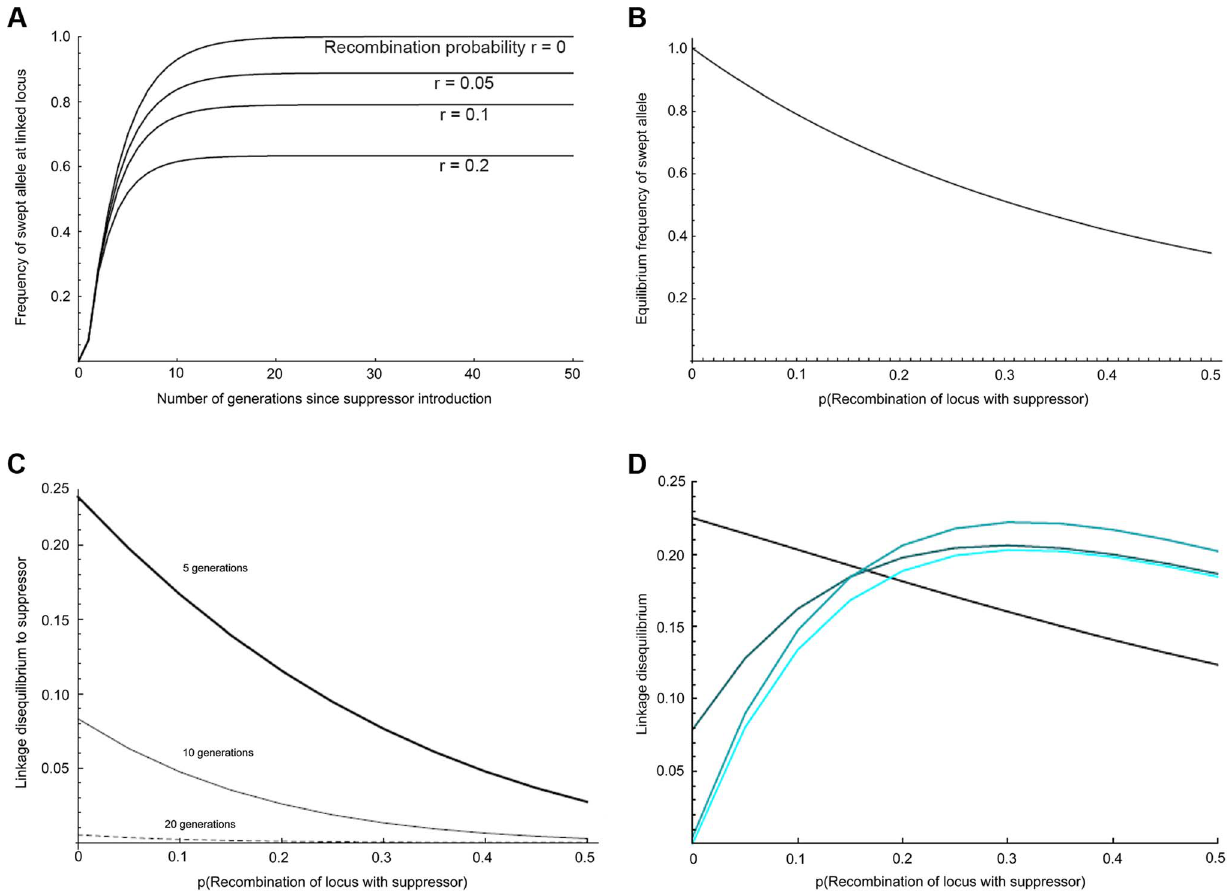
Figure 2. Predicted impact of selective sweep on the frequency and association of linked variants. a) Change in the frequency of initially associated linked variants over time at different recombination distances, b) Equilibrium frequency of initially associated linked variants at different recombination distances, c) Linkage disequilibrium to suppressor for loci at different recombination distance from suppressor after 5, 10 and 20 generations of selection, d) Local linkage disequilibrium between alleles with recombination probability of 0.01 at different recombination distances from the suppressor. The four curves show the situation after 5, 10, 20, and 40 generations (increasing lightness of colour corresponding to greater number of generations).